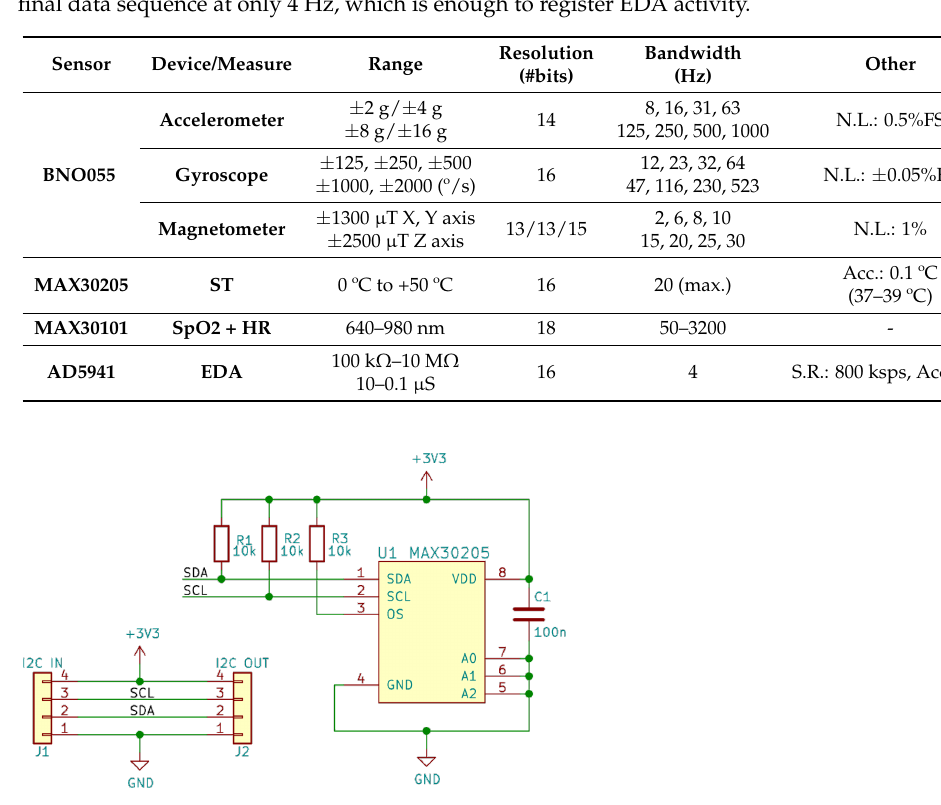
Figure 4. Circuit diagram for the ST sensor. This figure has been generated with KiCAD (https: //www.kicad.org, accessed on 14 June 2022). The names in green are the names of the Integrated Circuits. In red are the pin numbers of the